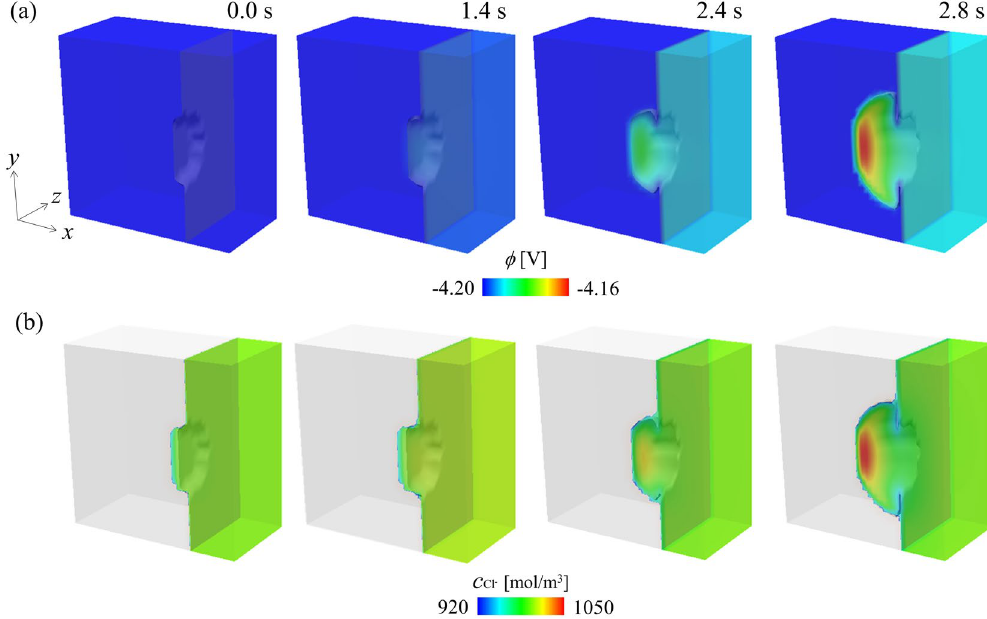
Figure 8. Evolutions of ( a ) electrostatic potential and ( b ) Cl − ion concentration during the pitting corrosion for 2.4